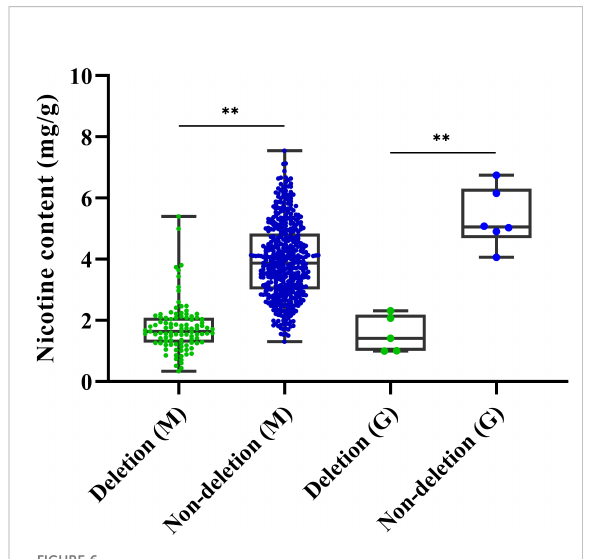
FIGURE 6 Boxplots for nicotine content of deletion type and non-deletion type in 560 MAGIC lines and germplasm resources. Signi fi cance level was calculated by one-way ANOVA (**P < 0.01, *P<